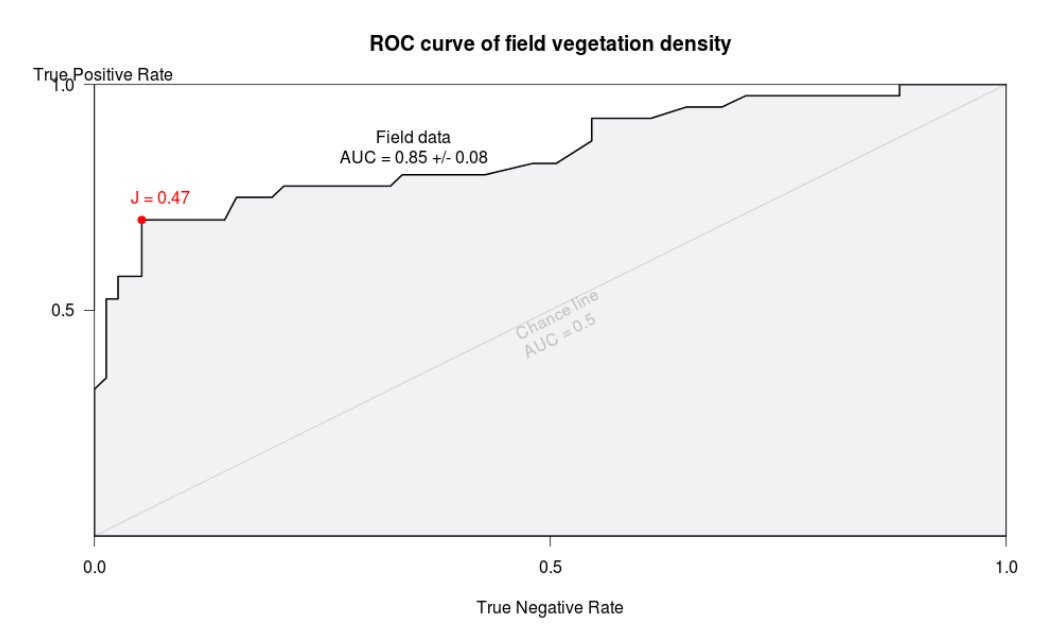
Figure 5. ROC curve for the field vegetation density ( n = 113). The best cut-off value (in red) corresponds to the optimal percentage of vegetation coverage for detection. The Youden index J identifies the threshold to be further used in the computation of the error matrices. The AUC of 84.9% indicates good performance compared to a random classifier. Table 2. Accuracy measures for the eight confusion matrices and the corresponding edge density metric. High overall accuracy is observed, but is strongly influenced by the agreement of non-vegetation pixels. During the dry season, omission and commission errors approach 60%–70% for every scene, but during rain, errors are reduced according to the north-south rainfall gradient. ED, edge density; OE, omission error; CE, commission error.